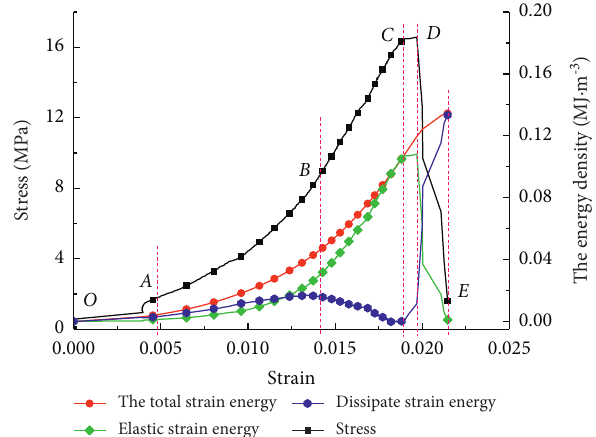
Figure 9: The relationship between stress, energy density, and strain under the uniaxial condition of rock sample with large pore